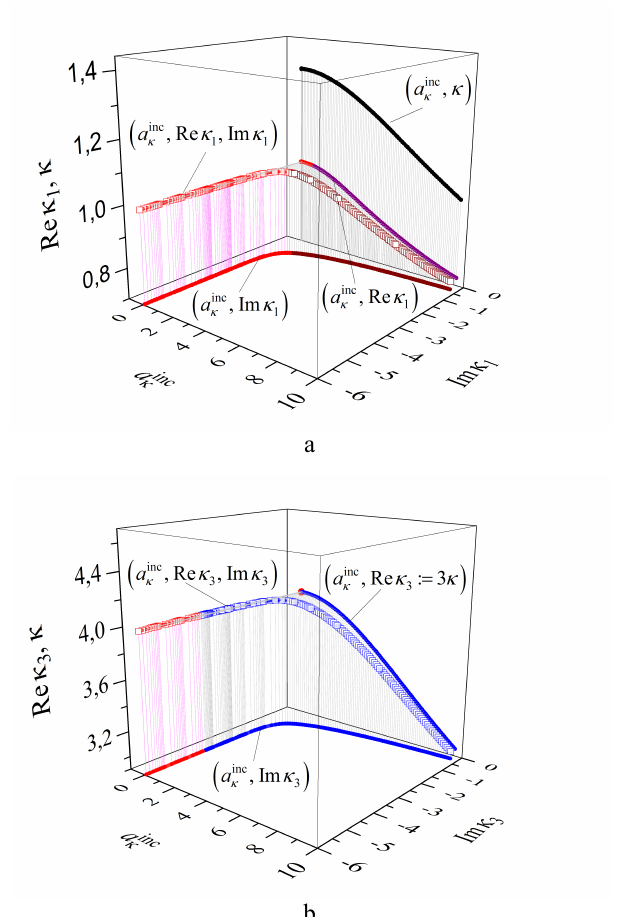
Figure 4: The eigen frequency branches at and their projections onto the co-ordinate planes (а) for and (b) for . The curves (а) of the excitation